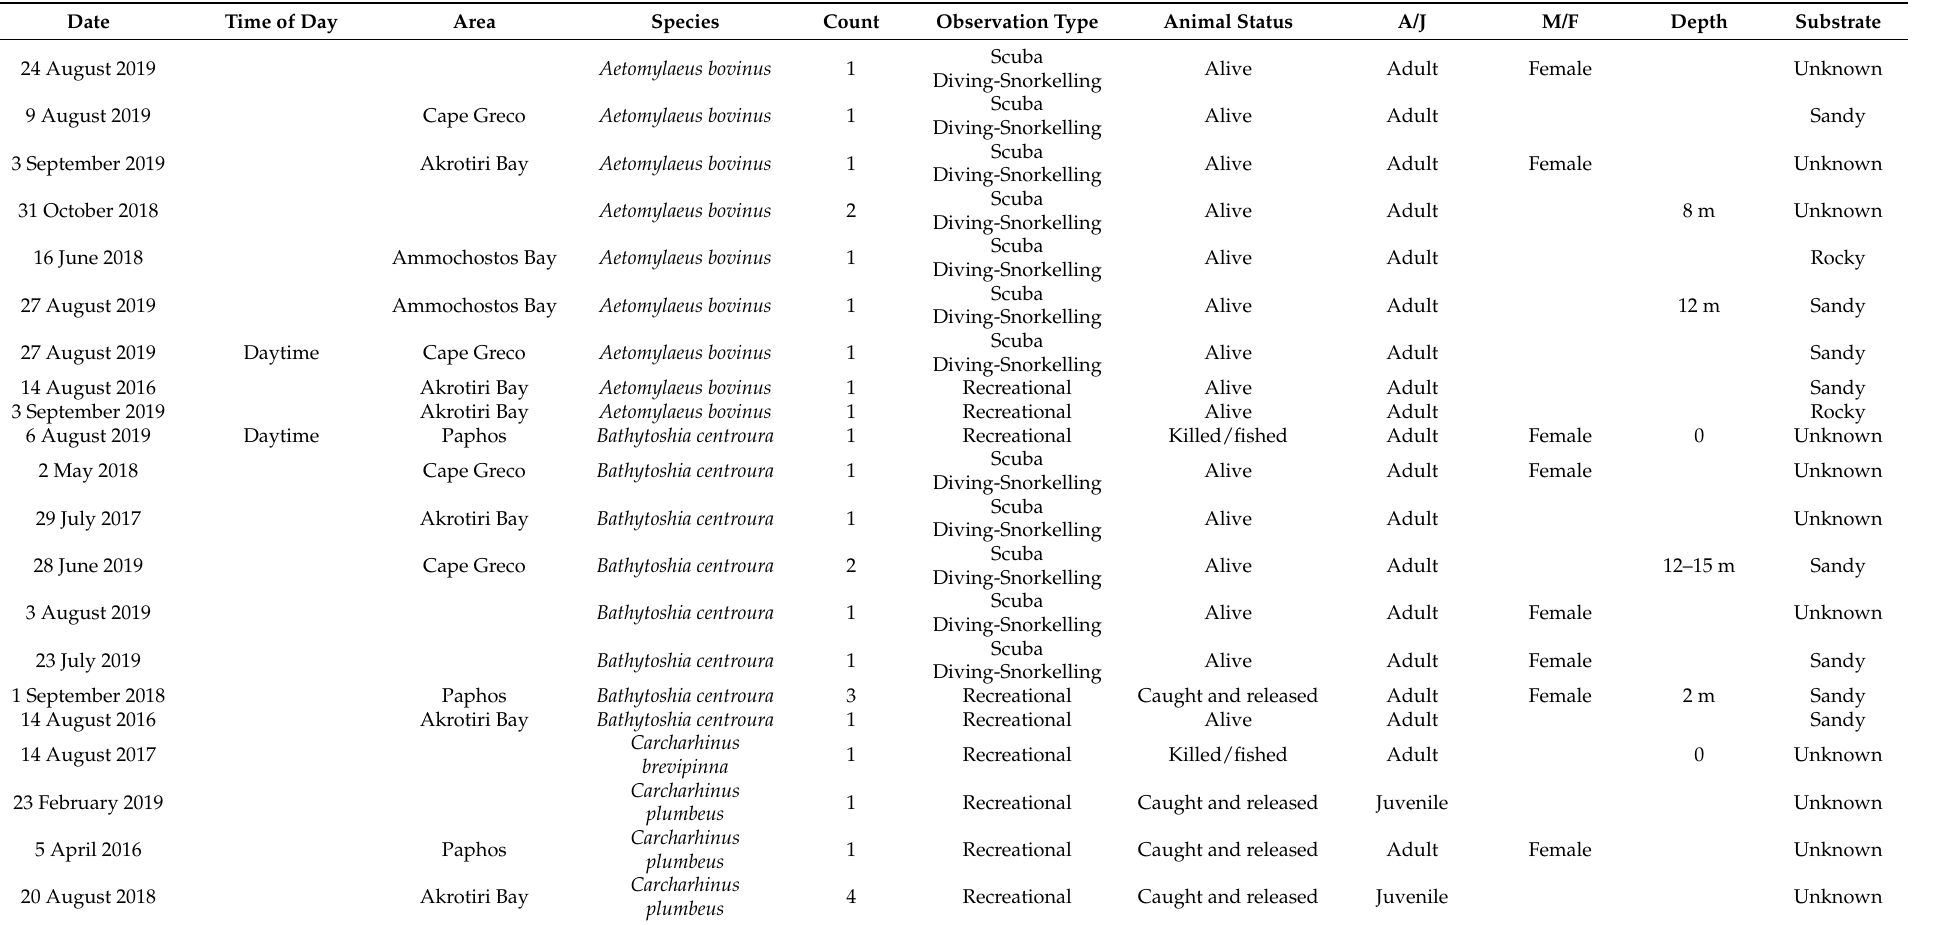
Table A1. Records of elasmobranchs reported to the Mediterranean Elasmobranchs Citizen Observations (MECO) project including information about the date, the area, the species, the number of individuals, the observation type, the animal status, the growth stage (A/J), the sex (M/F), the depth and the